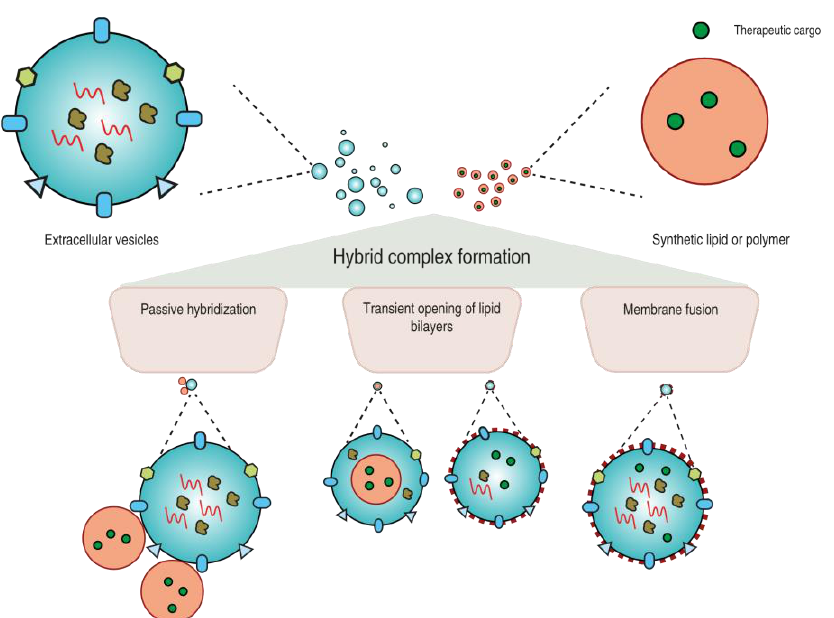
Figure 2. Production strategies for EV-based hybrid systems for drug delivery applications. Schematic illustration of the possible strategies to form EV-based hybrids with regard to final composition and architecture. Through passive hybridization, synthetic nanoparticles (sNPs) are most likely to interact with the EV surface or vice versa. The production strategy employing the transient opening of lipid bilayers (of either EVs or sNPs) may lead to multiple possible hybrid structures, which are determined by the sNP composition and hybrid formation conditions. Membrane fusion may allow hybrid formation without significant loss of sNP and EV cargo.